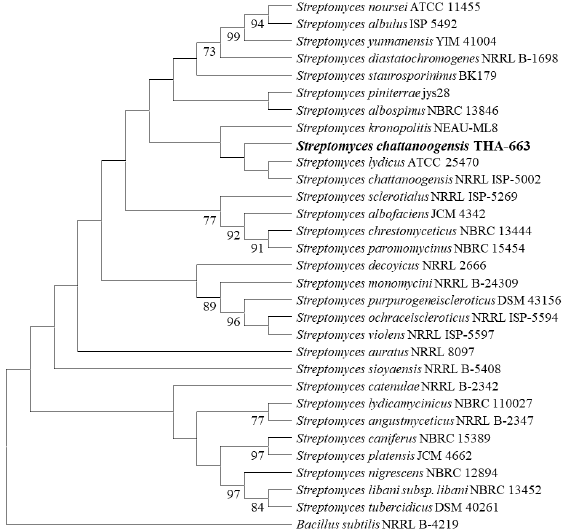
Figure 1. Phylogenetic tree of S. chattanoogensis THA-663. Bootstrap percentages (1000 replicates) above 70% are shown at the nodes and toggle-scaled the tree. Table 3. Antibacterial effect of THA-663S on MRSA.